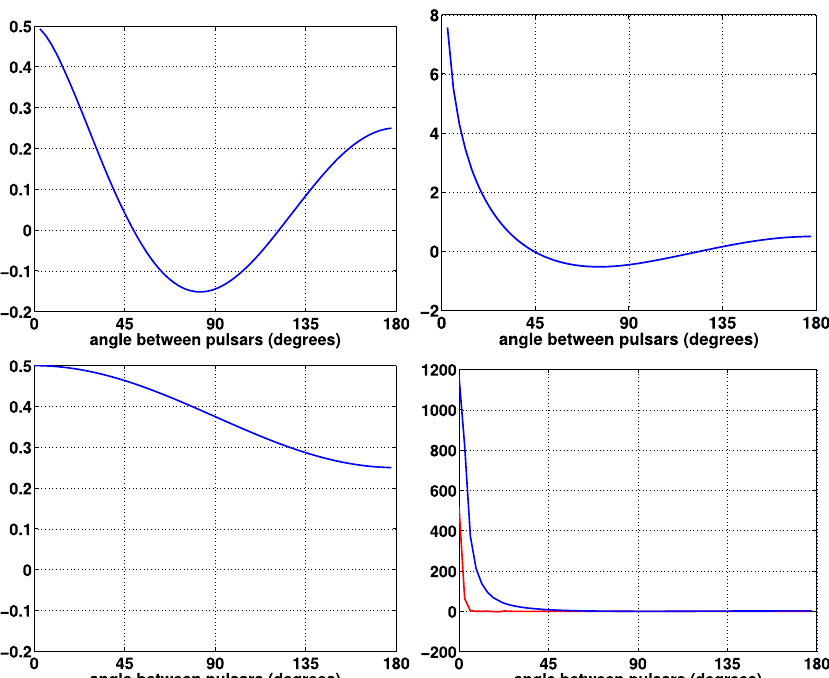
Fig. 68 Normalized overlap functions for the tensor ( upper left ), vector-longitudinal ( upper right ), breath- ing ( lower left ), and scalar-longitudinal ( lower right ) polarization modes, plotted as functions of the angular separation between pairs of pulsars. The blue and red curves in the lower right-hand plot correspond to the real and imaginary parts of the scalar-longitudinal overlap function. Note the different vertical scales for the vector-longitudinal and scalar-longitudinal overlap functions, compared to those for the tensor and breathing